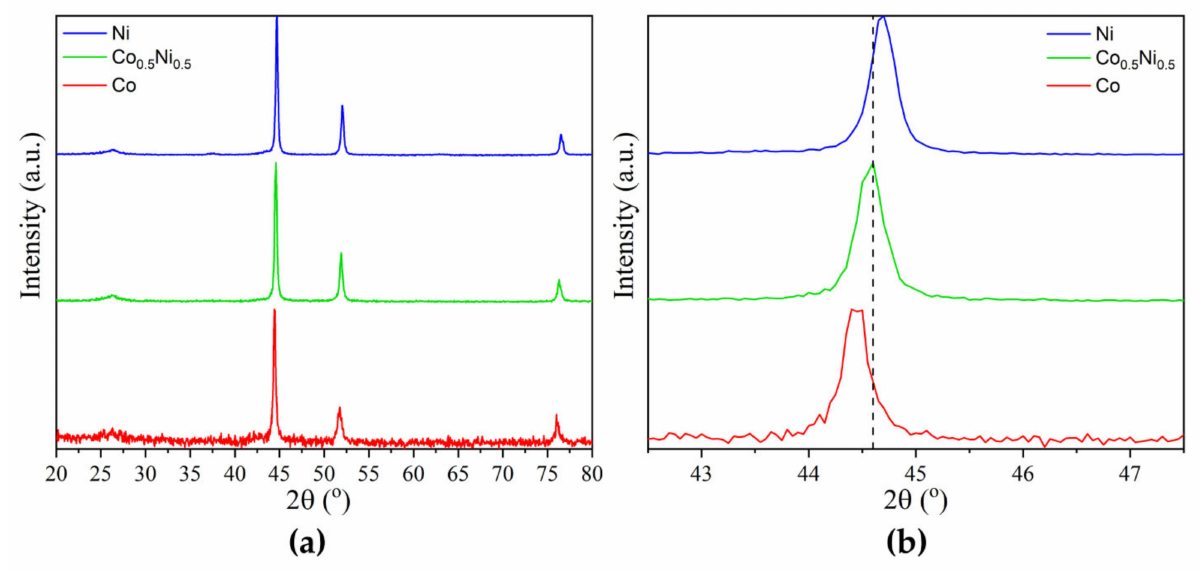
Figure 9. ( a ) Powder X-ray diffraction patterns obtained after the calcination of sity peak.